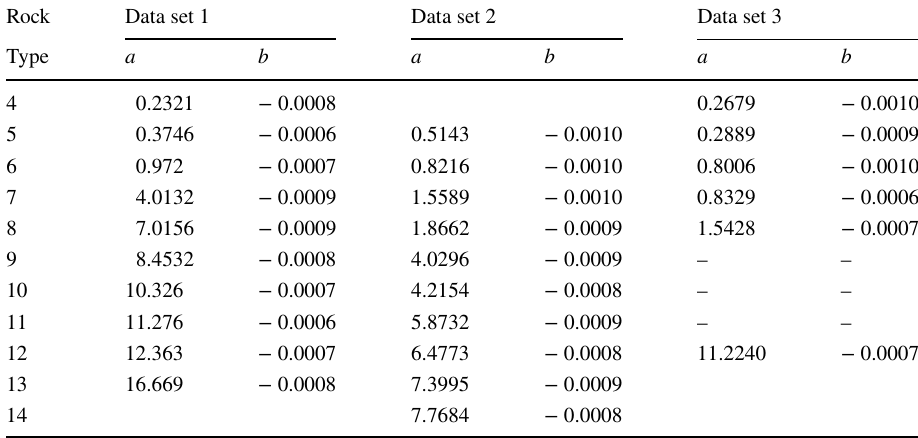
pdry and specific surface area